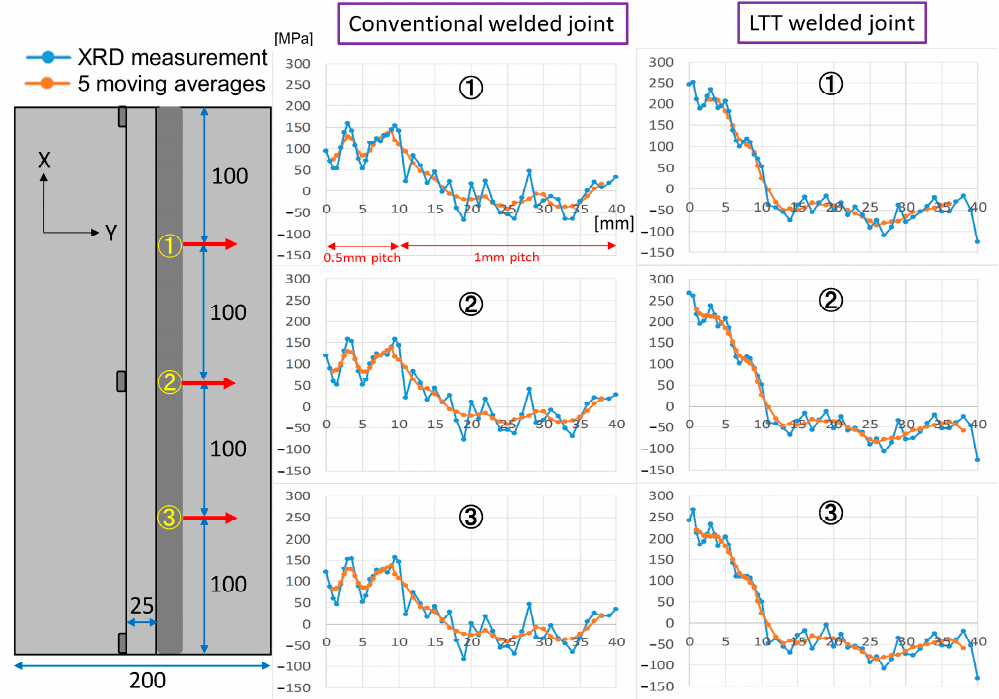
Figure 2. Measured residual Sy stress of the two welded joints.